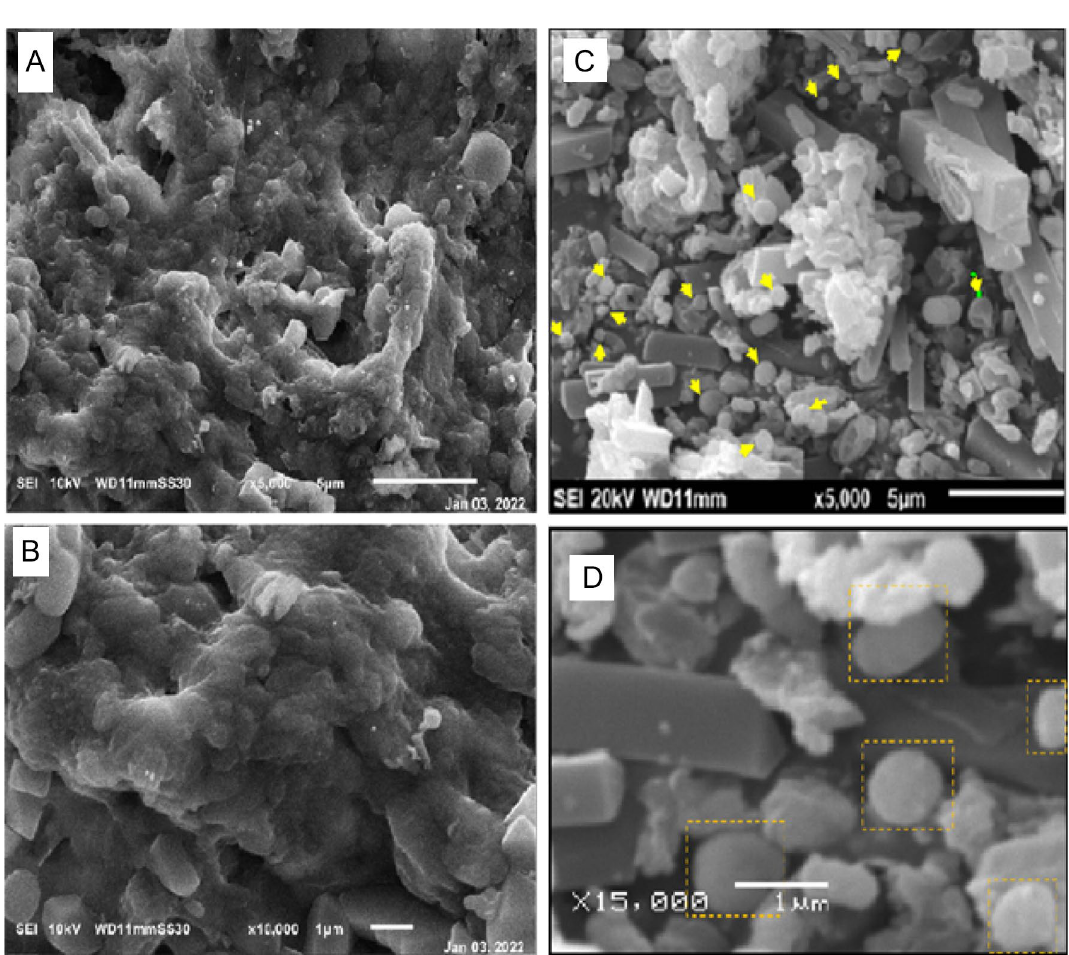
Figure 6. ( A , B ) Scanning Electron Microscope (SEM) micrograph of C. sinuosa algal aqueous extract and ( C , D ), Ag NPs synthesized by using C. sinuosa